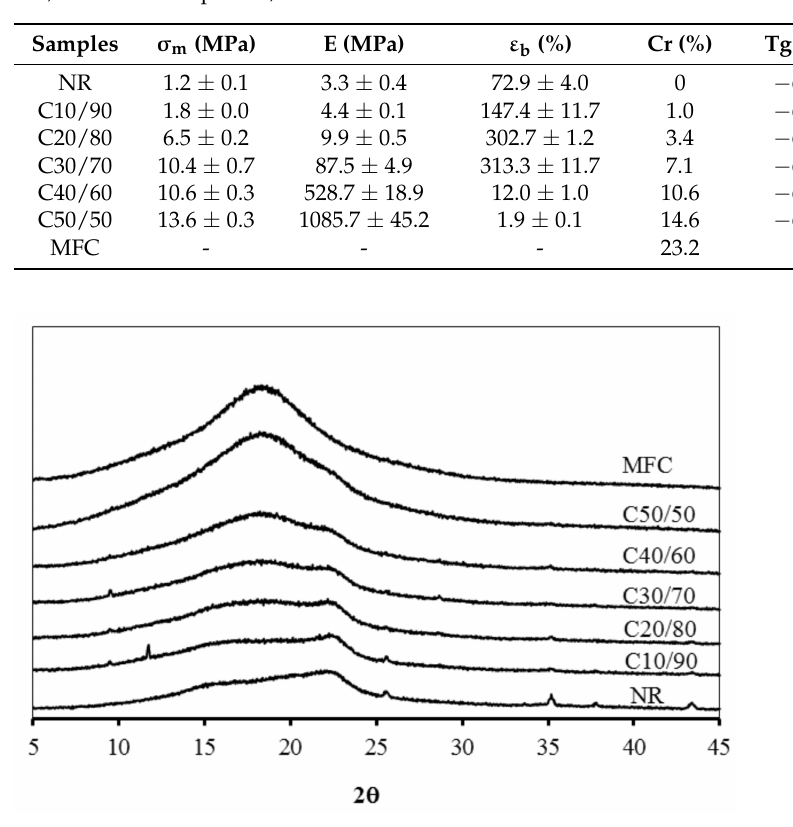
Figure 3. XRD patterns of MFC, MFC–NR composite, and NR